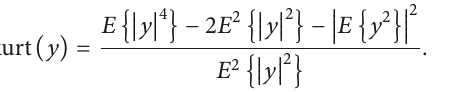
Figure 2: A common blind source separation